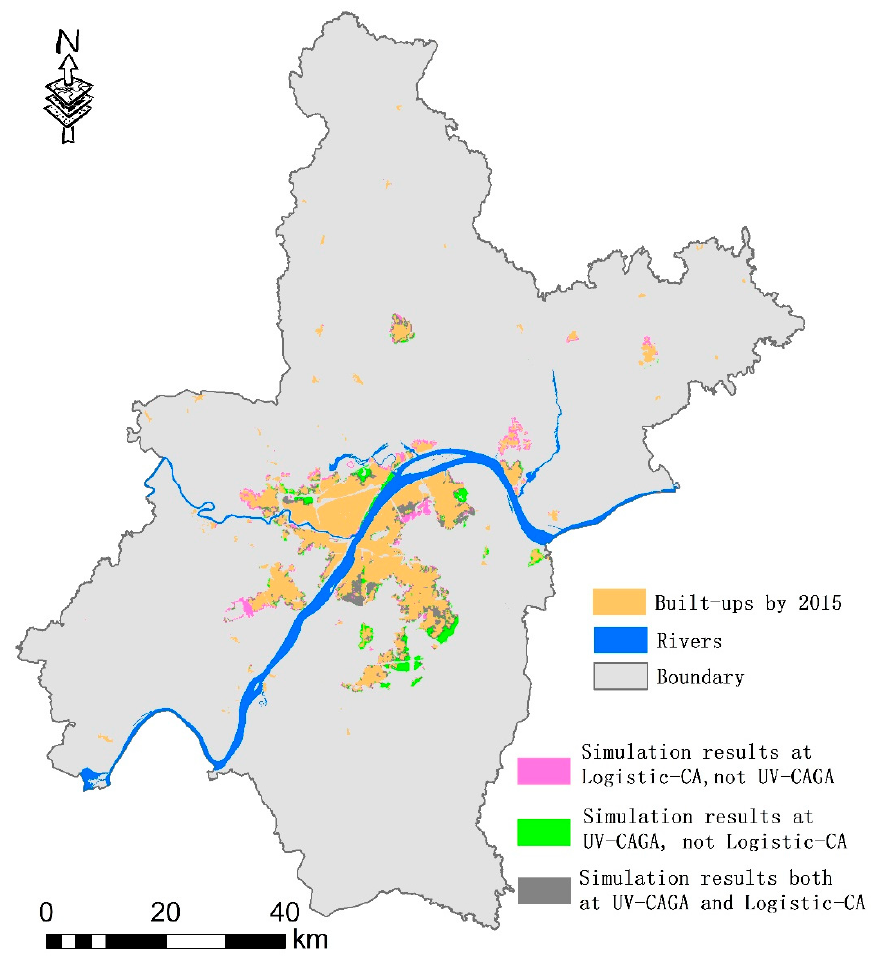
Figure 4. The simulation differences generated by the UV-CAGA and logistic CA models.